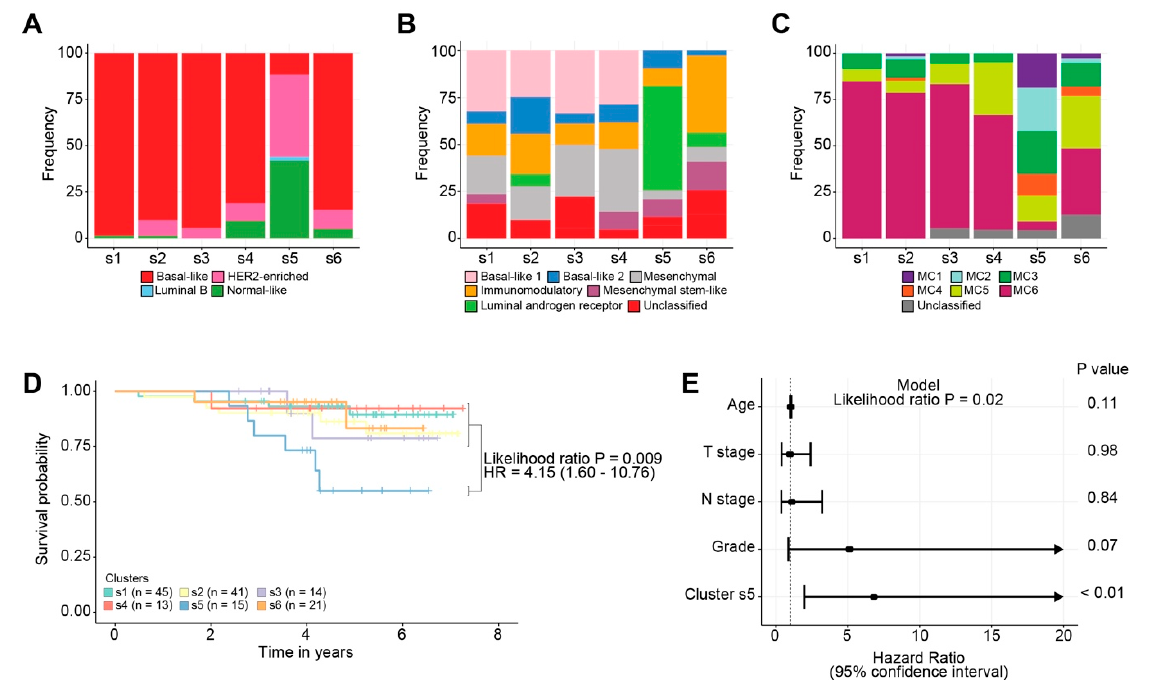
Figure 4. Permutation-based forest clustering derived clusters and clinical outcome in TNBCs from SCAN-B. Barplots illustrate the frequency (y-axis) of ( A ) PAM50, ( B ) TNBCtype, and ( C ) MC subtypes across the different clusters (x-axis). ( D ) Kaplan–Meier analysis of association with overall survival in SCAN-B. Only patients having received adjuvant chemotherapy ( n = 149) were considered for the analysis. ( E ) Forest plot of the multivariate Cox proportional hazards regression model on overall survival. The covariates that are adjusted in the multivariate model included age, T stage, N stage and grade. Arrows indicate confidence intervals that extend beyond the axis.